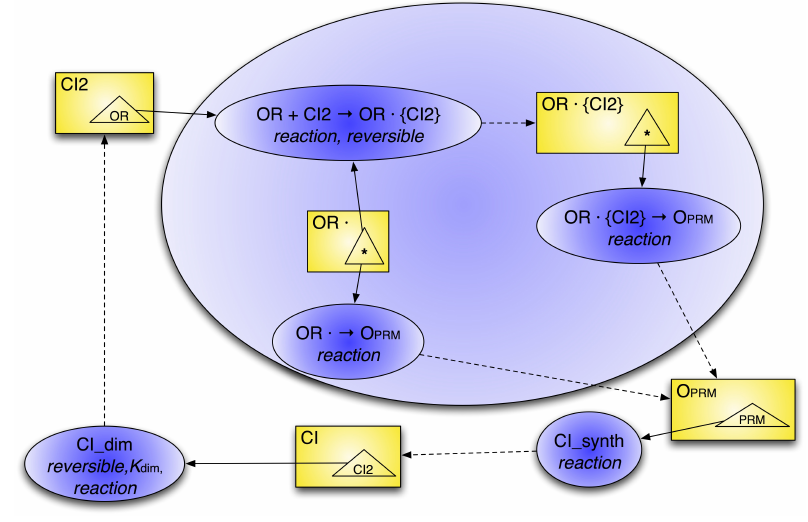
Figure 6: Transformation of the MIN from the Figure 2, ready for the translation. The influence of the CI species on the CI dim site contains the attribute “stoichiometry = 2” (not shown) as it is a dimerisation